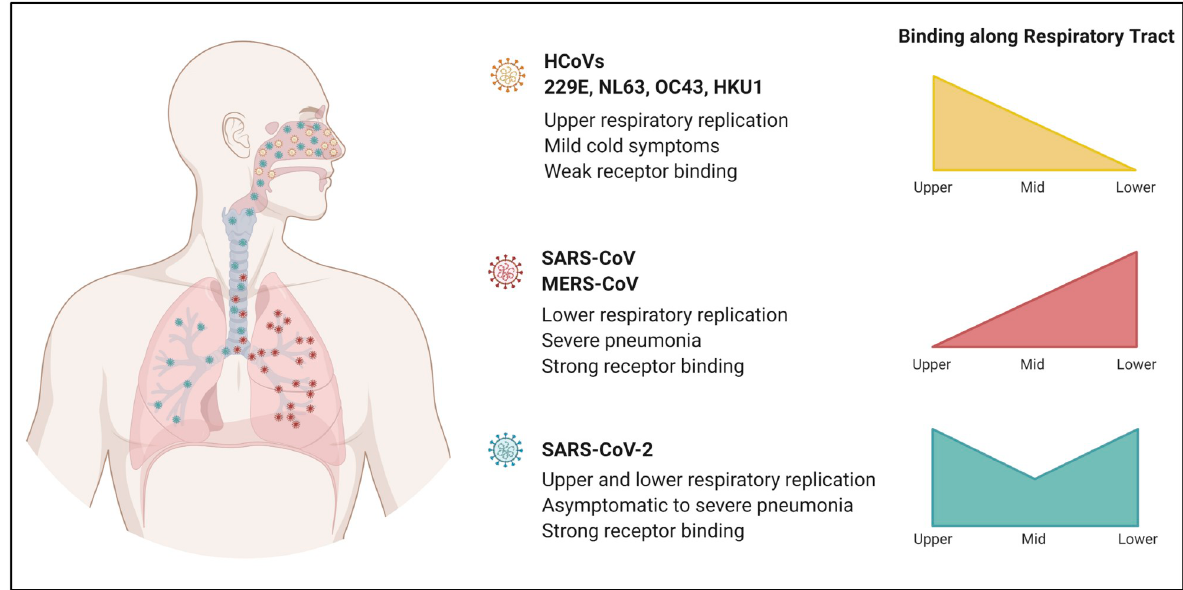
Fig 2. Comparison of CoV tropism. Less pathogenic hCoVs replicate in the upper respiratory tract, while highly pathogenic SARS-CoV and MERS-CoV are found to replicate in the lower respiratory tract. Viral replication is not typically observed in the mid airways for both groups. Although concentrated in the upper and lower airways, viral replication of SARS-CoV-2 has been detected throughout the respiratory tract. The ability of SARS-CoV-2 to infect and replicate throughout the airways allows for greater range in transmissibility and pathogenicity. The figure was generated using BioRender software. CoV, coronavirus; hCoV, human coronavirus; MERS-CoV, Middle East Respiratory Syndrome Coronavirus; SARS-CoV, Severe Acute Respiratory Syndrome Coronavirus; SARS-CoV-2, Severe Acute Respiratory Syndrome Coronavirus 2.